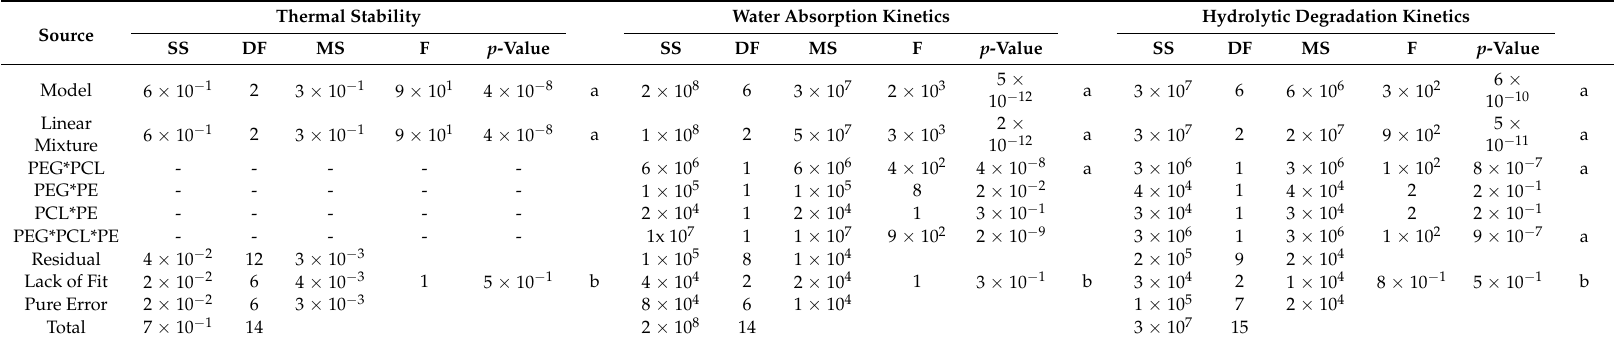
Table 3. ANOVA test of model regression for thermal stability, water absorption kinetics and hydrolytic degradation